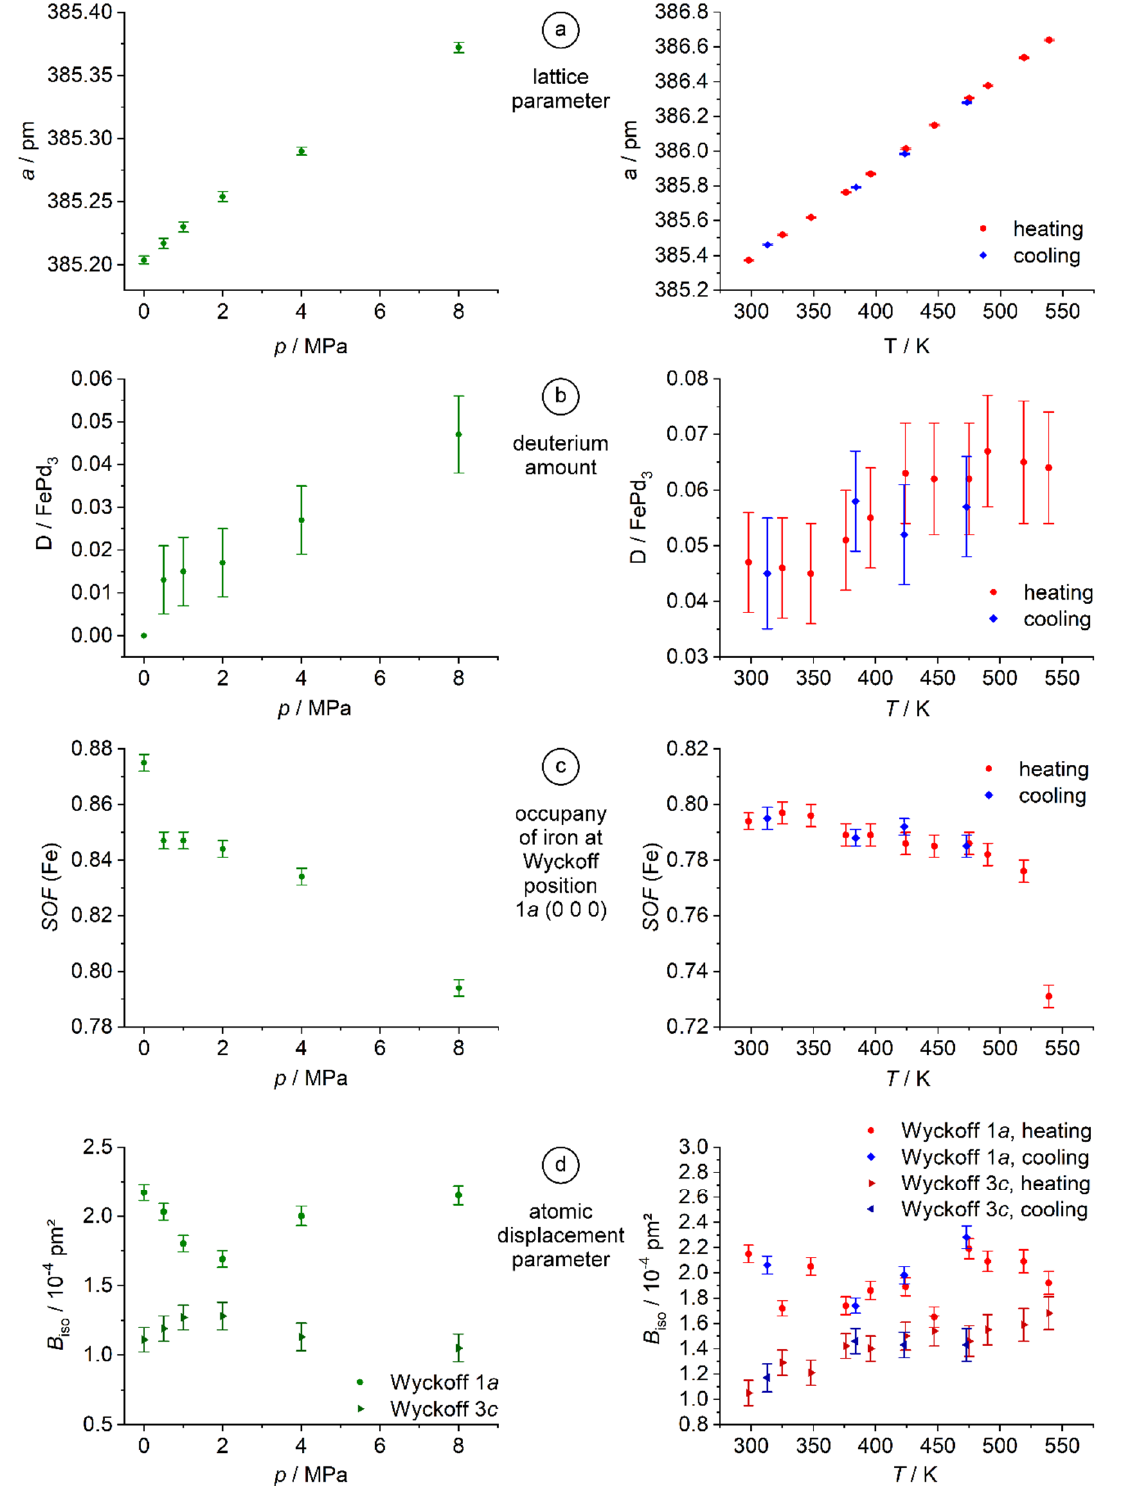
Figure 4. Refined structural parameters of ordered FePd 3 during isothermal increase in deuterium pressure (left, NUMOR 131613-131746 [21], T = 298(2) K) and isobaric variation of the temperature (right, NUMOR 131746-131894 [21], p (D 2 ) = 8.2(2) MPa) based on in situ neutron powder diffraction data: lattice parameter ( a ), deuterium content per formula unit ( b ), SOF of iron at Wyckoff position 1 a ( c ) and atomic displacement parameters of the metal atoms ( d ). Error bars represent ± σ .